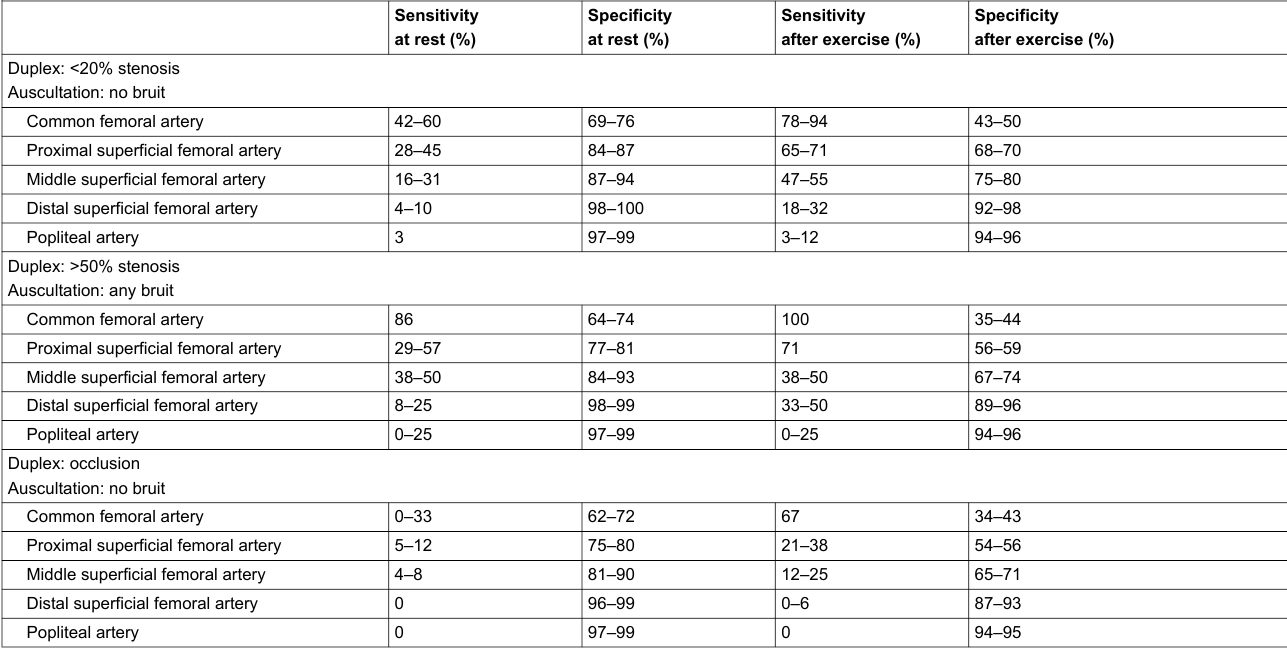
Table 4: Sensitivity and specificity of femoropopliteal auscultation in different vascular regions (range from the different raters).